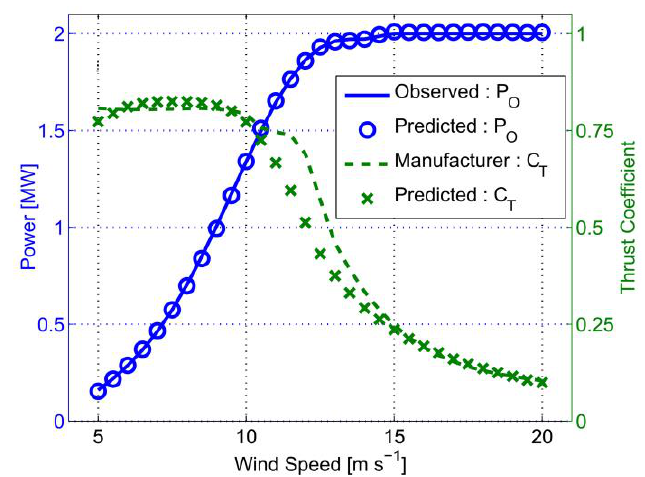
Figure 4. Measured and simulated power curve and thrust coefficient curve of the Vestas V-80 2 MW wind turbine, for a range of wind speeds (Source: Wu and Porté-Agel, 2014).